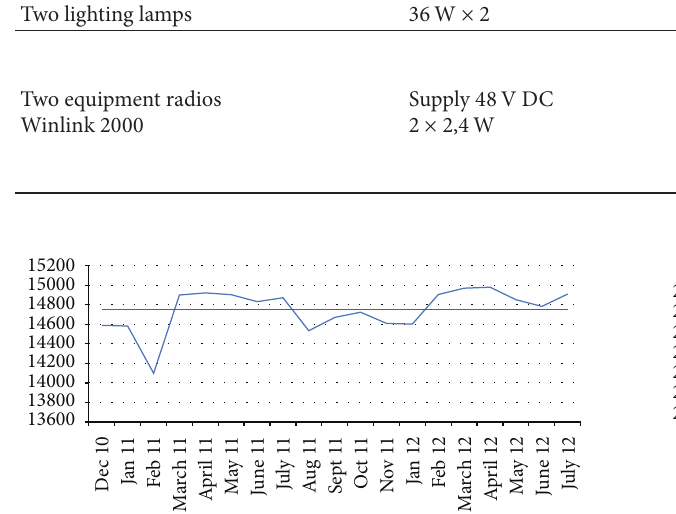
Figure 4: Estimation costs curve for monthly energy consumption, CRTV site from December 10 to July